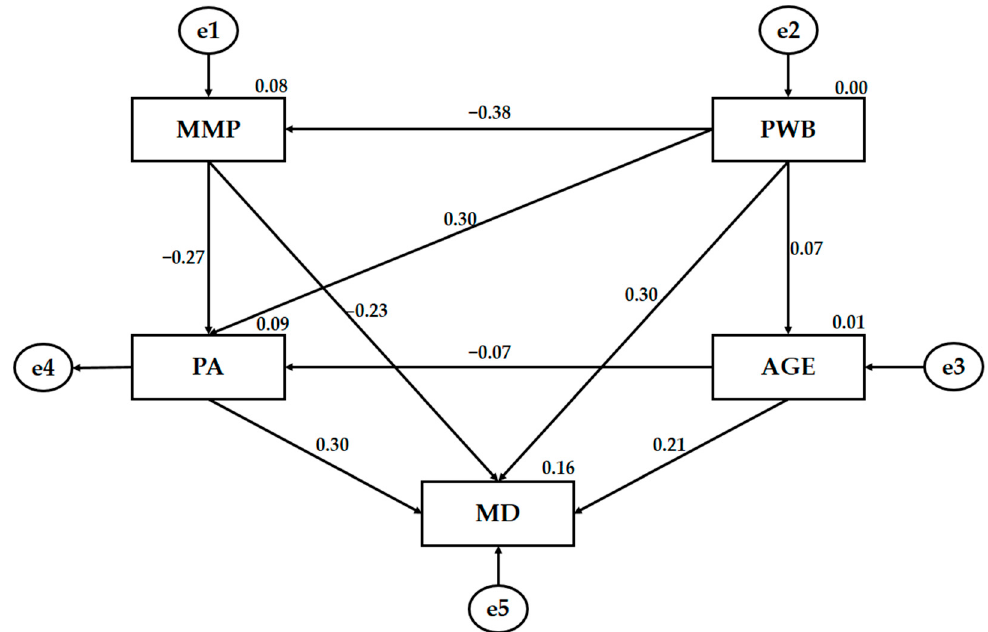
Figure 3. The structural equation for the theoretical model. Note: Mass media pressure (MMP); Mediterranean diet (MD); physical activity (PA); psychological well-being (PWB); age (AGE); error (e). Table 1. The structural model for the theoretical model. Associations between